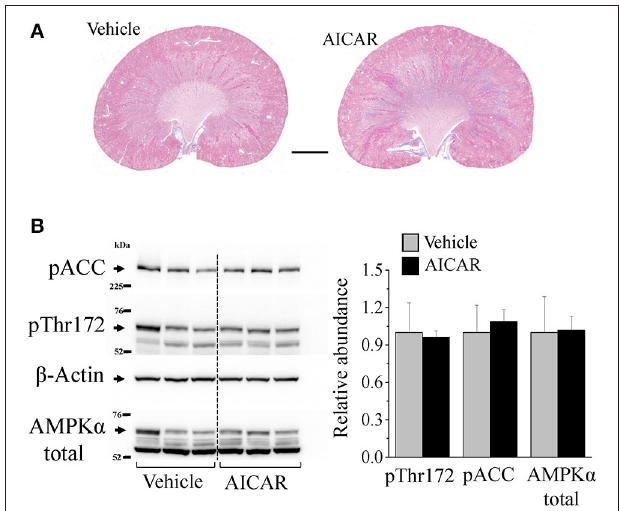
FIGURE 6 | AICAR treatment does not affect renal damage and cortical AMPK activity. (A) Kidney morphology. Trichrome staining revealed that AICAR treatment did not preclude renal damage in SS hypertension. Scale bar = 2 mm. (B) Abundance of total AMPK α , phosphorylated Thr172-AMPK α and phosphorylated acetyl-CoA carboxylase (pACC), a canonical target of AMPK were studied in the renal cortex collected from the infused animals. No difference in AMPK activity was found between the